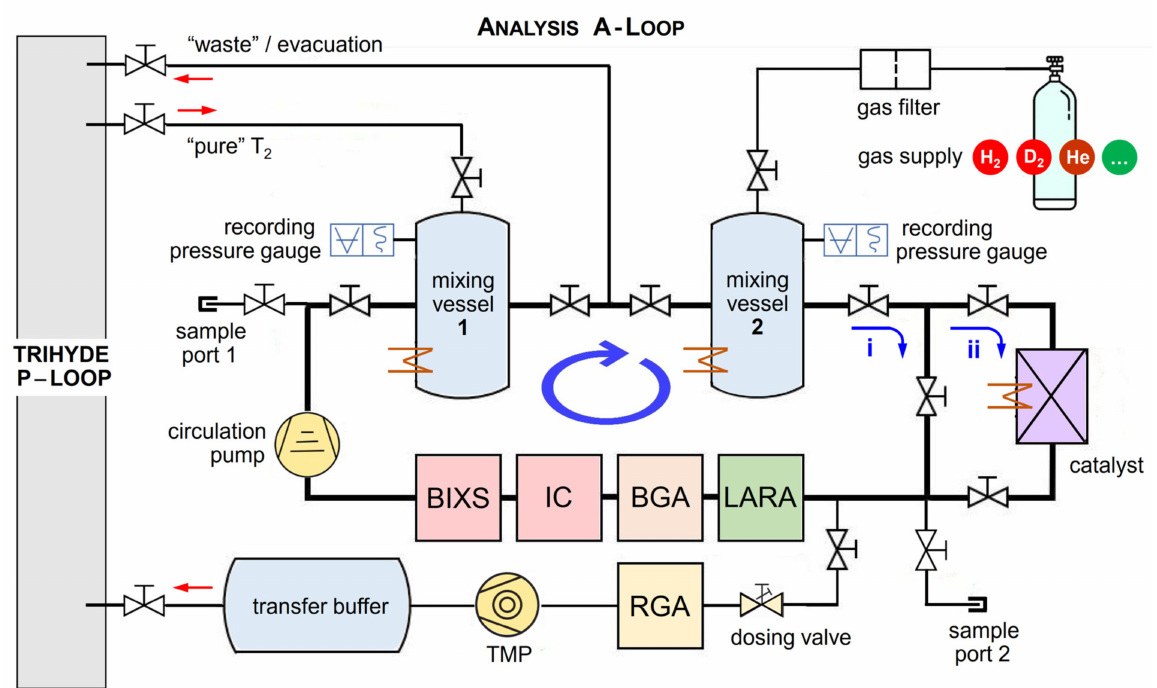
Figure 3. Schematic of the analysis segment of TRIHYDE—the A-Loop. It comprises two volume-calibrated buffer vessels and a series of in-line measurement instruments; optionally, the circulating gas can be directed to pass through a catalyst (to speed up equilibrating/exchange reactions). For compositional analysis: LARA = laser Raman spectroscopy cell, BGA = binary gas analyzer; for activity monitoring: IC = ionization chamber, BIXS = beta-induced X-ray spectrometry unit. In addition, off-line compositional rest gas analysis (RGA) via mass spectrometry is incorporated. Gases can be admitted from the tritium transfer system, from external gas supplied, or via two sample ports. For details, see